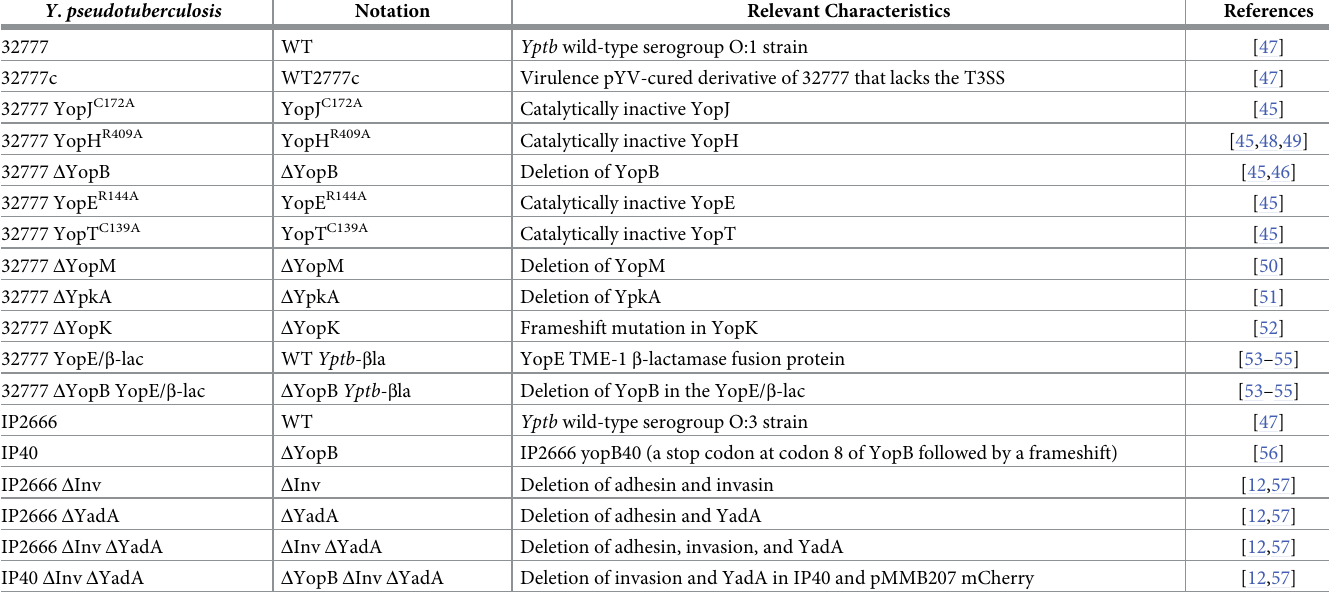
Table 1. Y . pseudotuberculosis strains and mutants used in this study. Y .